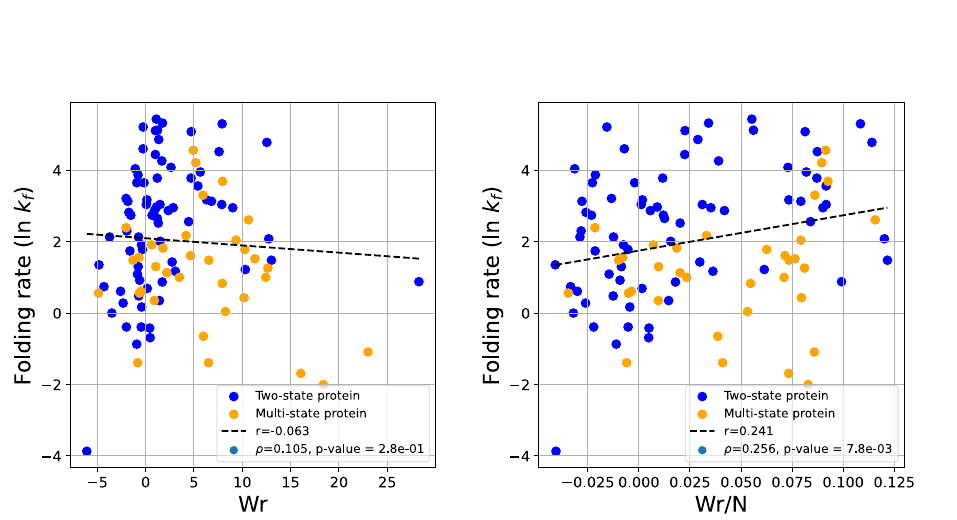
Figure 4. The protein folding rate as a function of the writhe (left) and writhe/N (right) for all proteins in the data set. The folding rate is represented as the natural log of the experimental folding rate k f